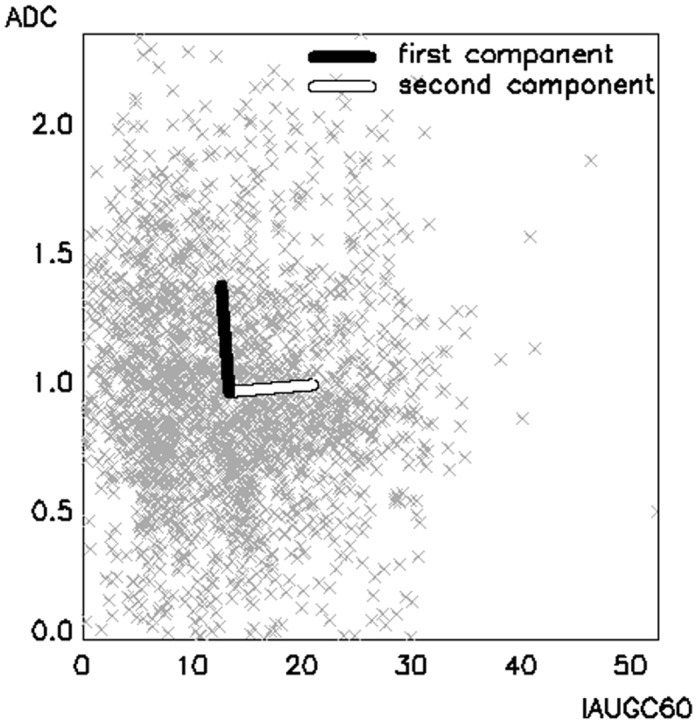
Principal component analysis.Principal component analysis in the bi-dimensional space formed by the two parameters IAUGC60 and ADC. The two vectors represent the two orthogonal components. The length of the two vectors is proportional to the weight of each component. IAUGC60 is expressed in units of mmol·s, ADC in units of ×10−3 mm2/s.